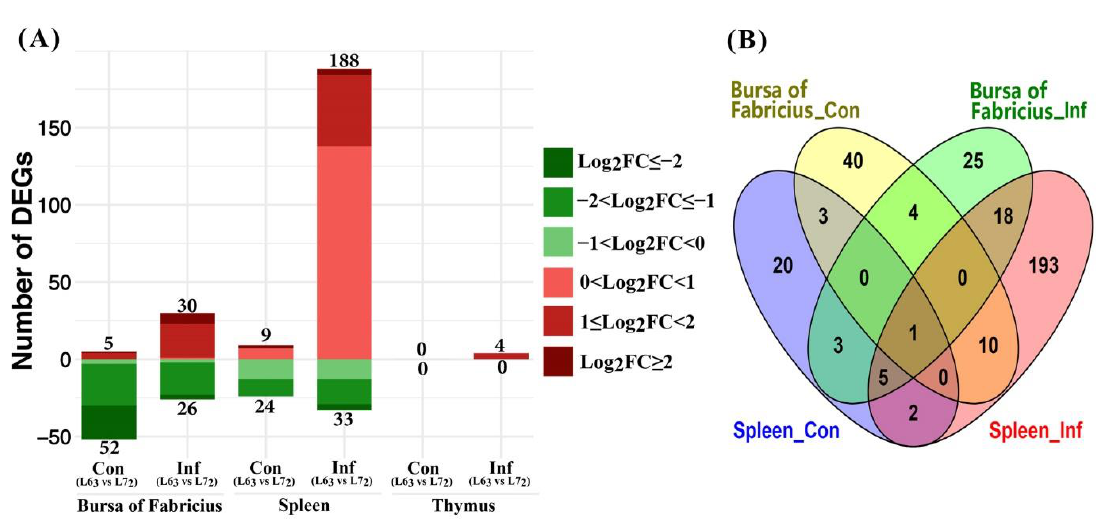
Figure 4. Differentially expressed mitochondria-related nuclear genes between the two lines chickens under each treatment (FDR ≤ 0.1). ( A ) Number of up- or down-regulated DEGs in three lymphoid organs. Up-regulated and down-regulated genes are displayed in red and green color, separately. Color density indicates different range of Log 2 fold change (log 2 FC). ( B ) Venn diagram showing the number of overlapped DEGs in bursa of Fabricius and spleen from the control and infected groups.